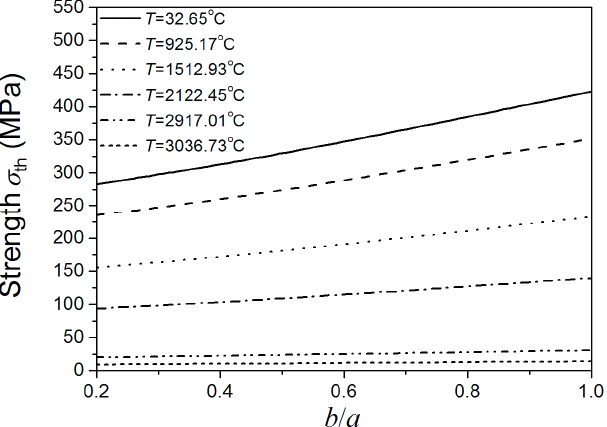
Figure 6. b / a ratio dependence of the material’s fracture strength under different temperatures ( b is a definite